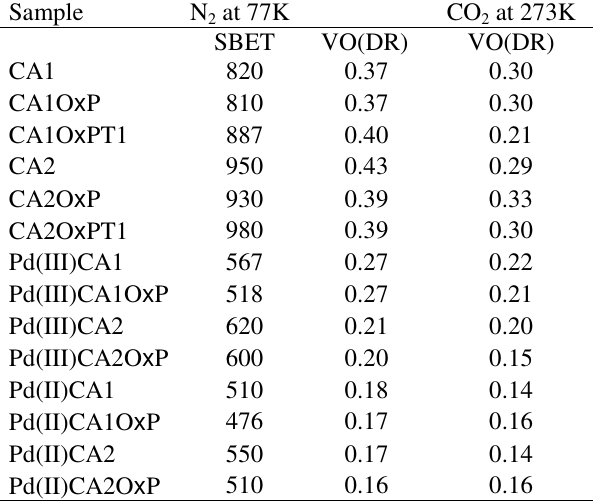
Table 1. Superficial areas and micropores volume corresponding to the employed carbonaceous